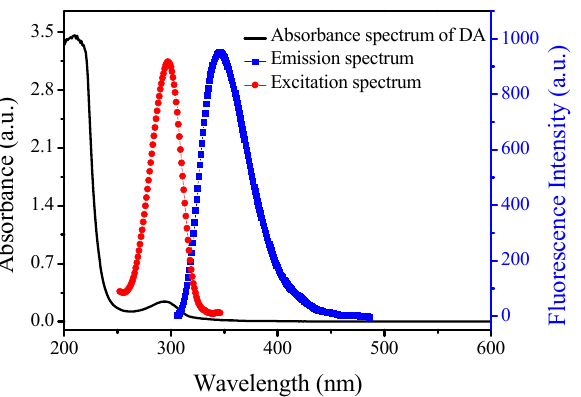
Figure 5. UV-vis absorption spectrum of DA, and emission and excitation spectra of the C-dots. In general, fluorescence quenching includes dynamic quenching and static quenching, even a mixture of the two. Static quenching is a quenching process caused by the complex reaction of quencher and fluorescent molecules in the ground state. In order to explore the quenching mechanism of DA on C-dots, the fluorescence intensities of the C-dots were compared, and the plots were drawn at 25, 35, 45 and 55 ◦ C, respectively. Figure 6 shows that the F 0 / F of C-dots is dependent on the concentration of DA at different temperatures, and it conforms to the Stern–Volmer equation in its dynamic quenching effect as follows: